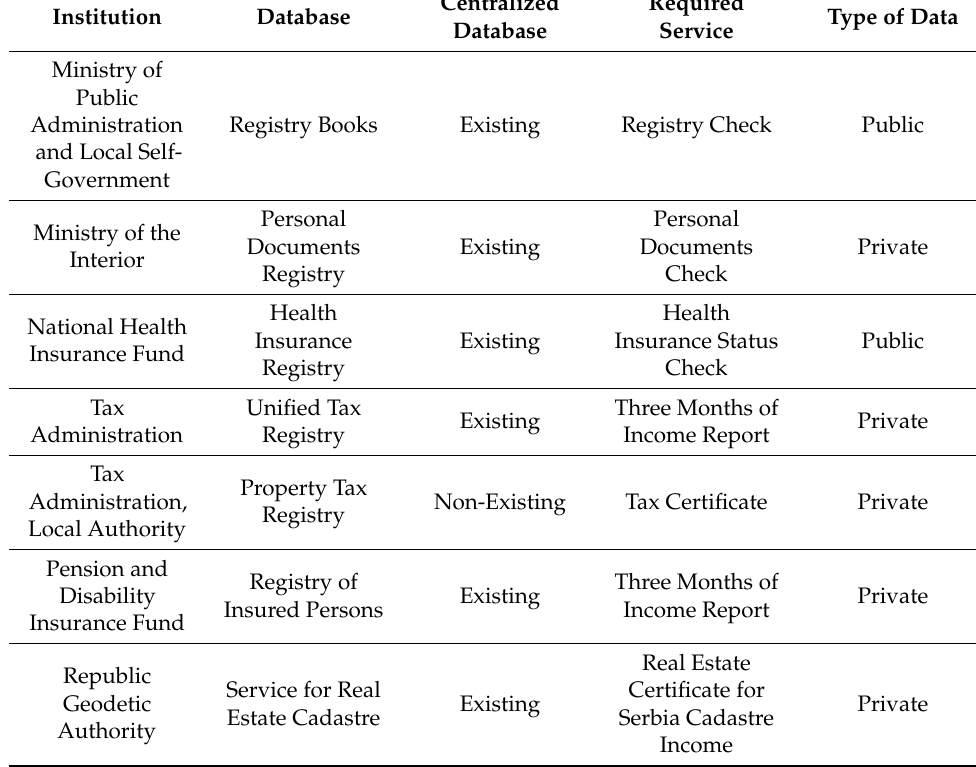
Table A1. Documents, their locations, and services that the competent institution should provide for the functioning of the child-benefits system (example of